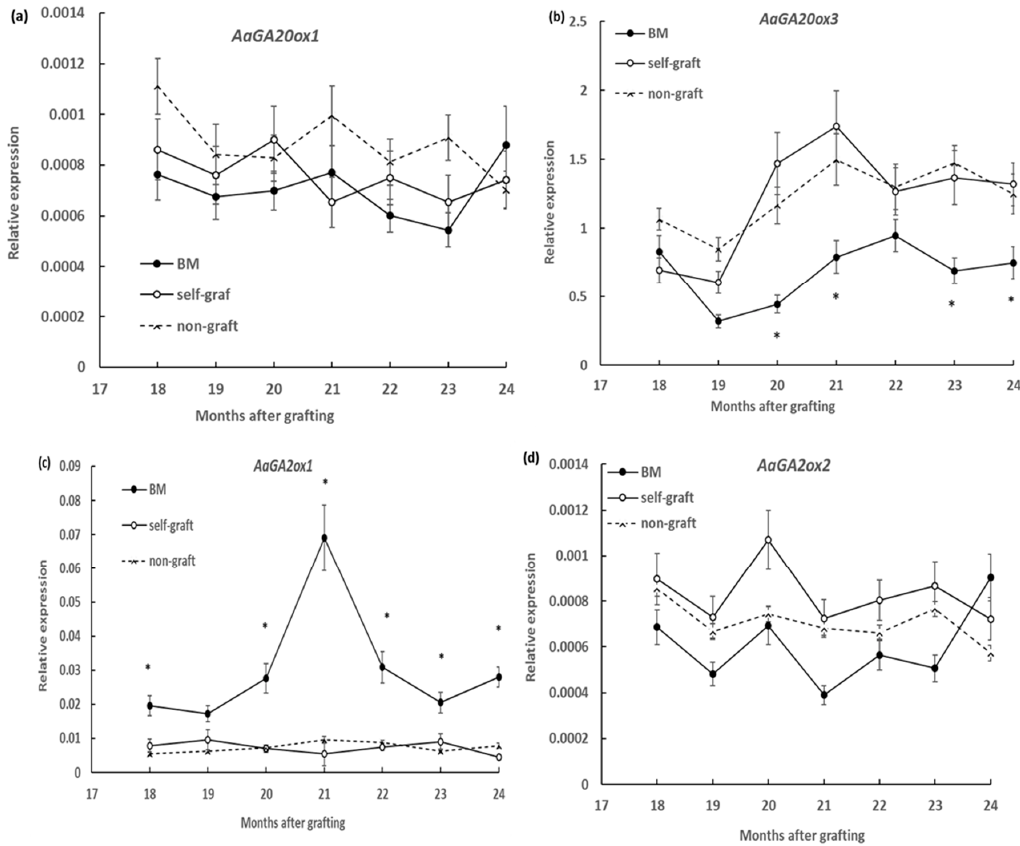
Figure 2. Effect of rootstocks on the expression of gibberellin (GA) biosynthetic genes, AaGA20ox1 and AaGA20ox3 , and GA catabolic genes, AaGA2ox1 and AaGA2ox2 , in breadfruit scion stems: Expression level of each transcript was normalized to the expression of the actin gene. BM, breadfruit plants growing on marang rootstocks. All values represent mean ± SE from five separate RNA extractions (* p < 0.05). ( a ) AaGA20ox1 ; ( b ) AaGA20ox3 ; ( c ) AaGA2ox1 and ( d ) AaGA2ox2 .